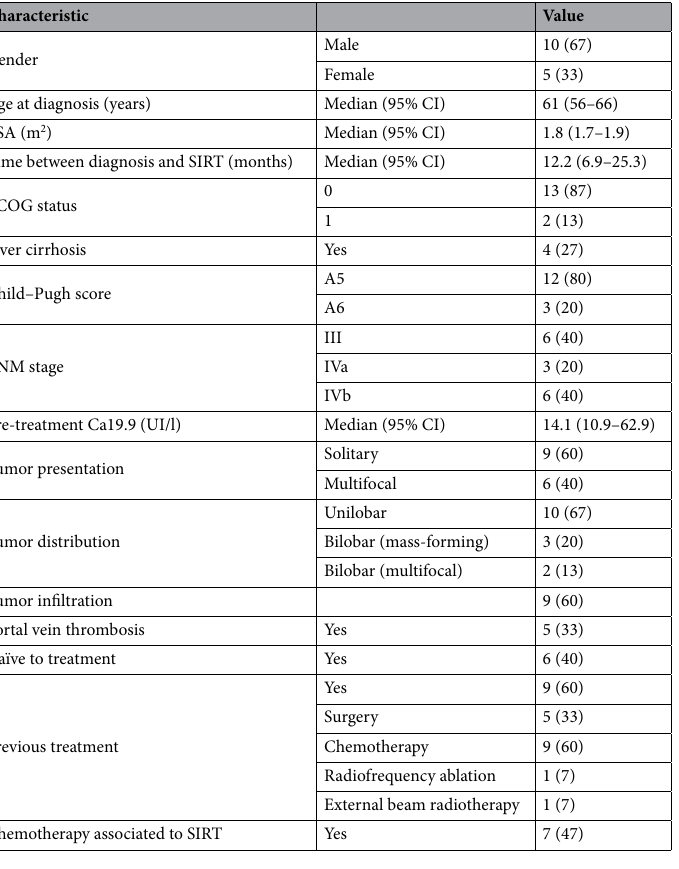
Table 1. Baseline clinical characteristics. When not otherwise specified data are expressed as numbers (percentages). BSA body surface area, SIRT selective internal radiation therapy, ICC intrahepatic